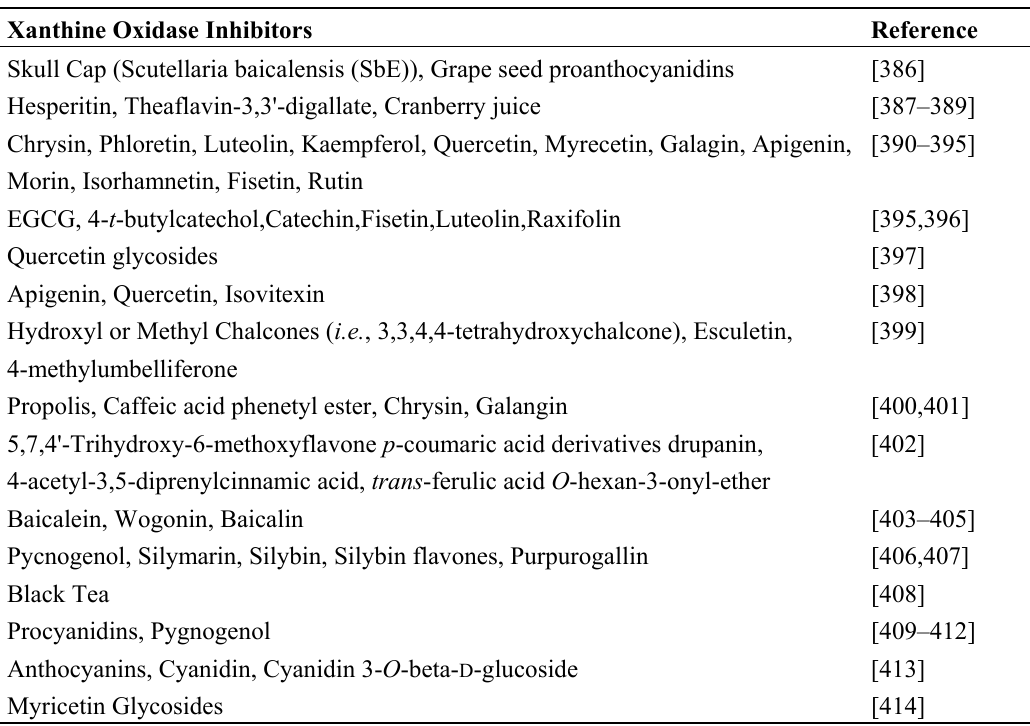
Table 5. Xanthine Oxidase